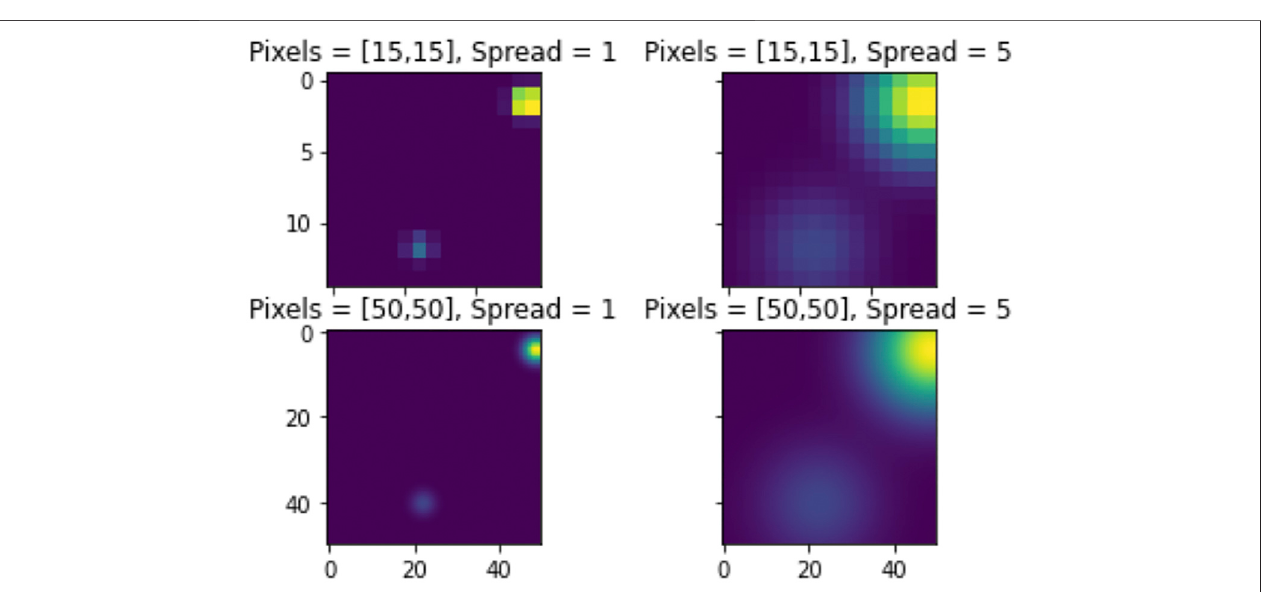
FIGURE 7 | Persistence Images of a 5 from the MNIST set in dimension